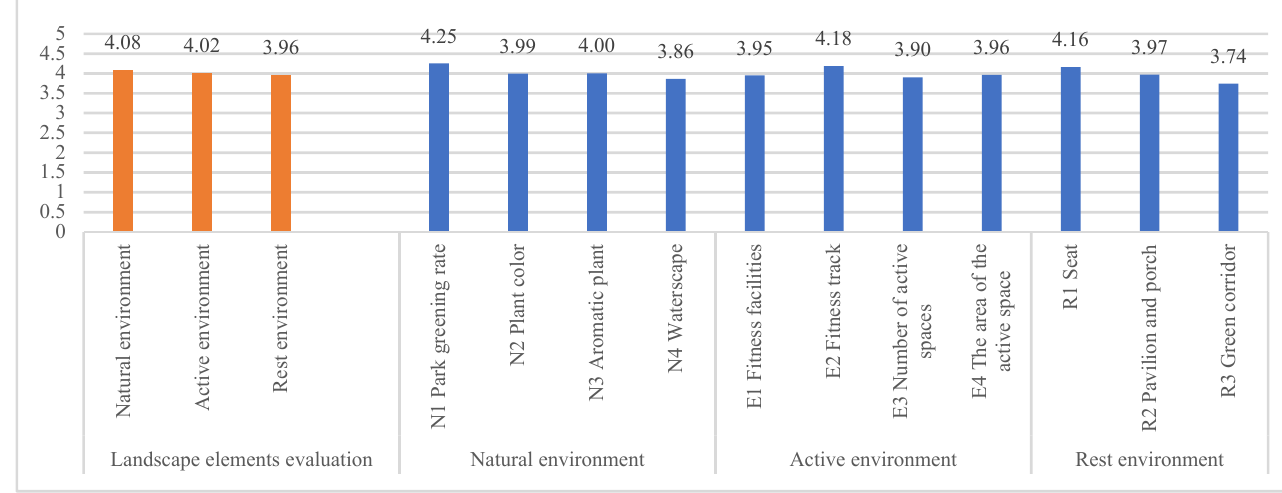
Figure 11. Evaluation statistics of landscape elements by community park users.